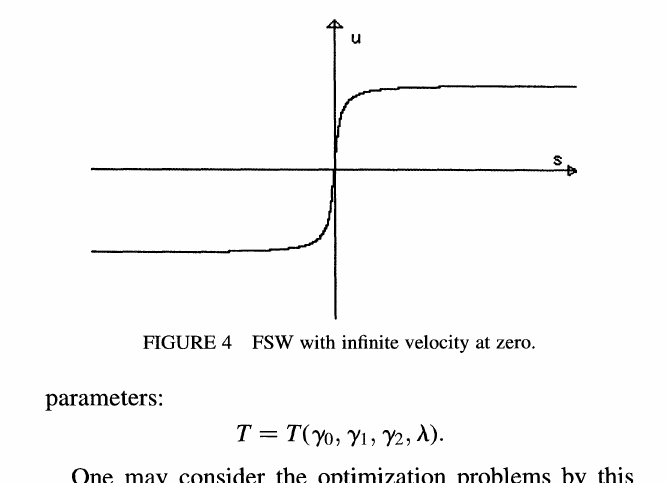
FIGURE 4 FSW with infinite velocity at